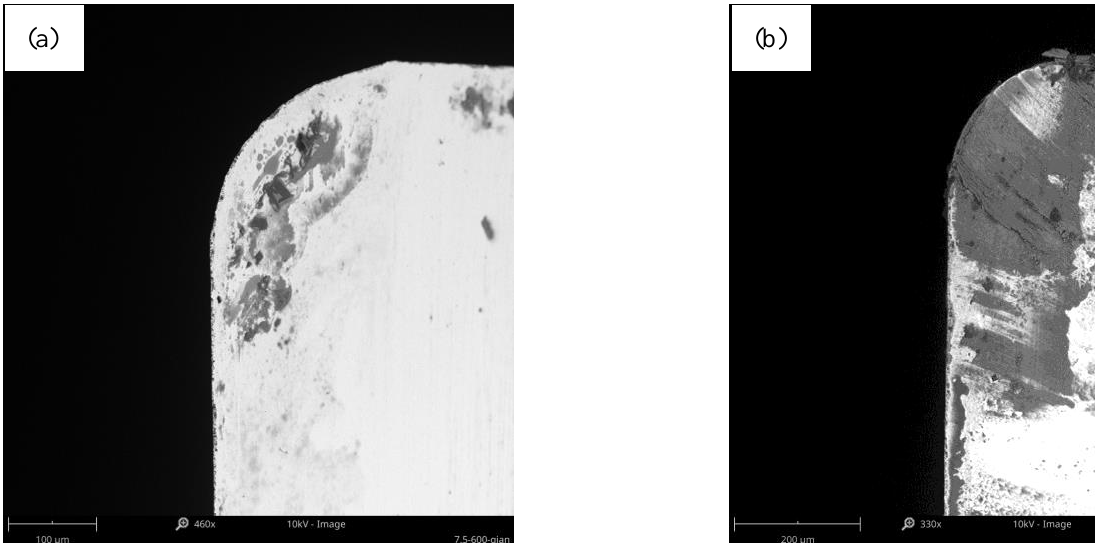
Figure 13. The relationship between the cutting force and VB at different cutting parameters. the adhesive layer. The change rate of cutting force and the change rate of the wear rate of the tool surface tends to be stable when the adhesive layer is formed.